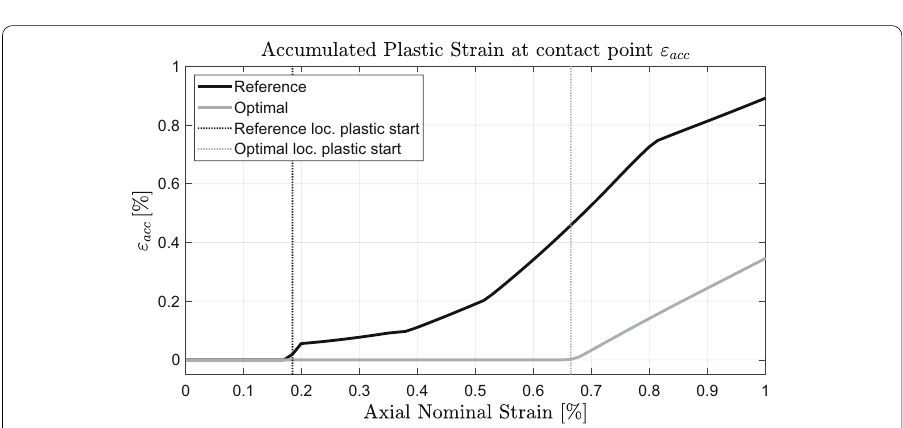
Fig.10 Plot showing the evolution of the stress concentration at the contact point (corresponding to point 1 in Fig. 8) with the applied macro-elongation. As plastification starts, γ decreases due to the local plastification